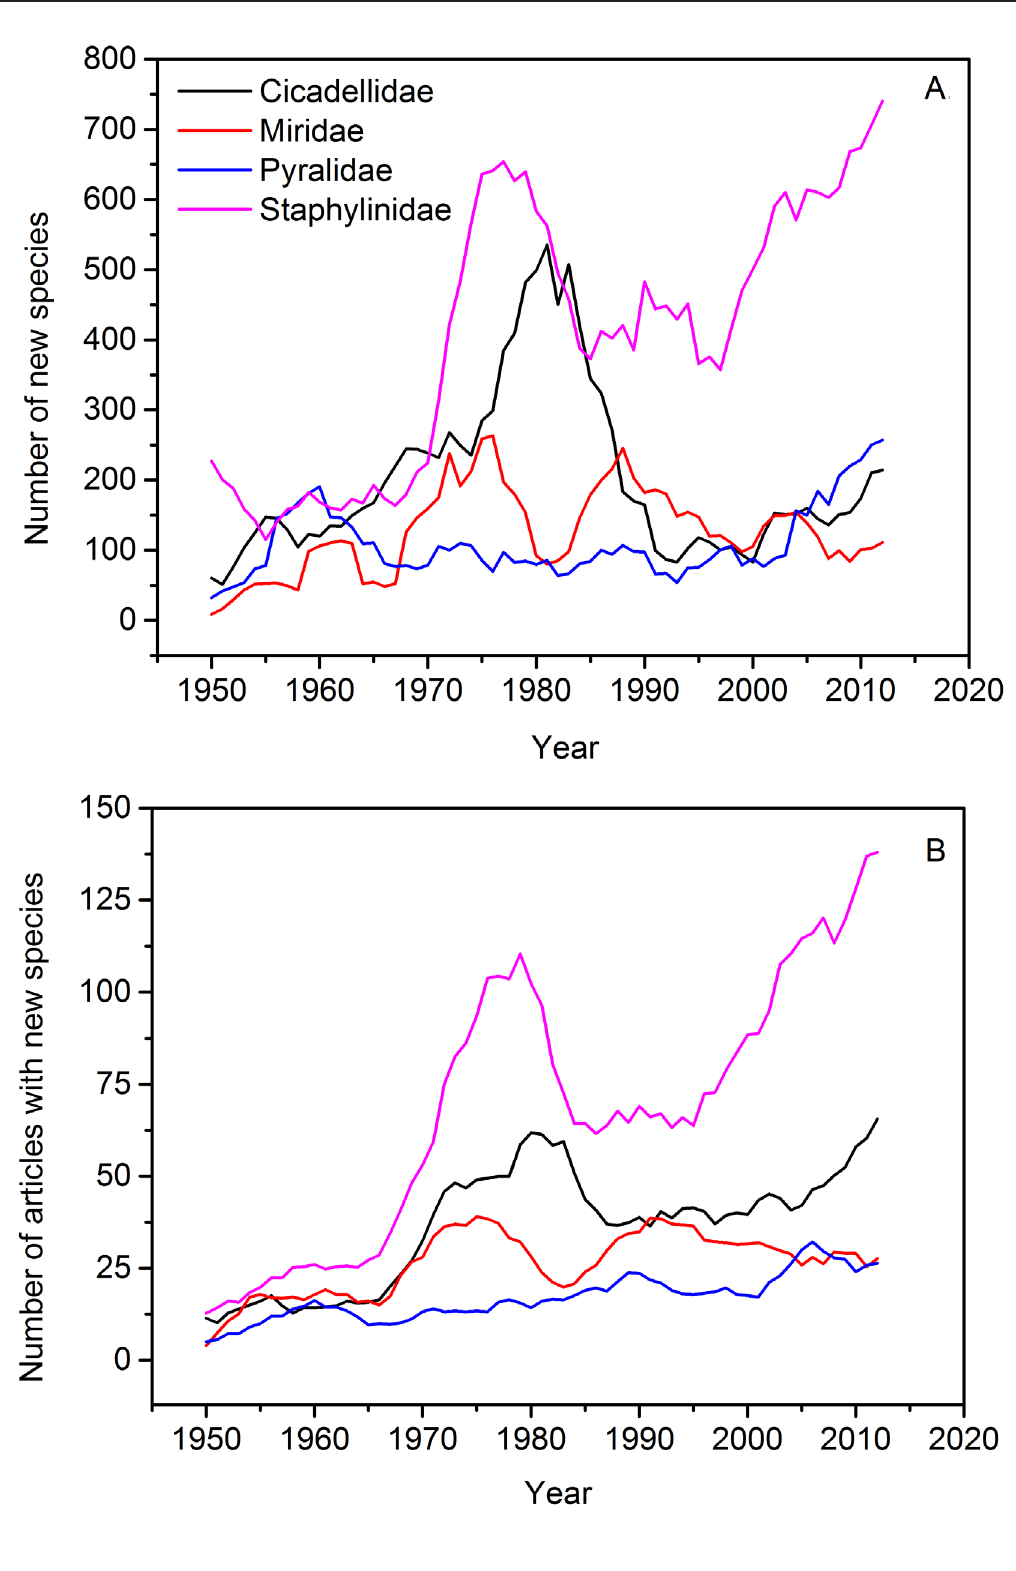
Fig 1. Time series of newly described species for the families Cicadellidae, Miridae, Pyralidae and Staphylinidae between 1946 and 2012. A . Number of new species. B . Number of articles with new